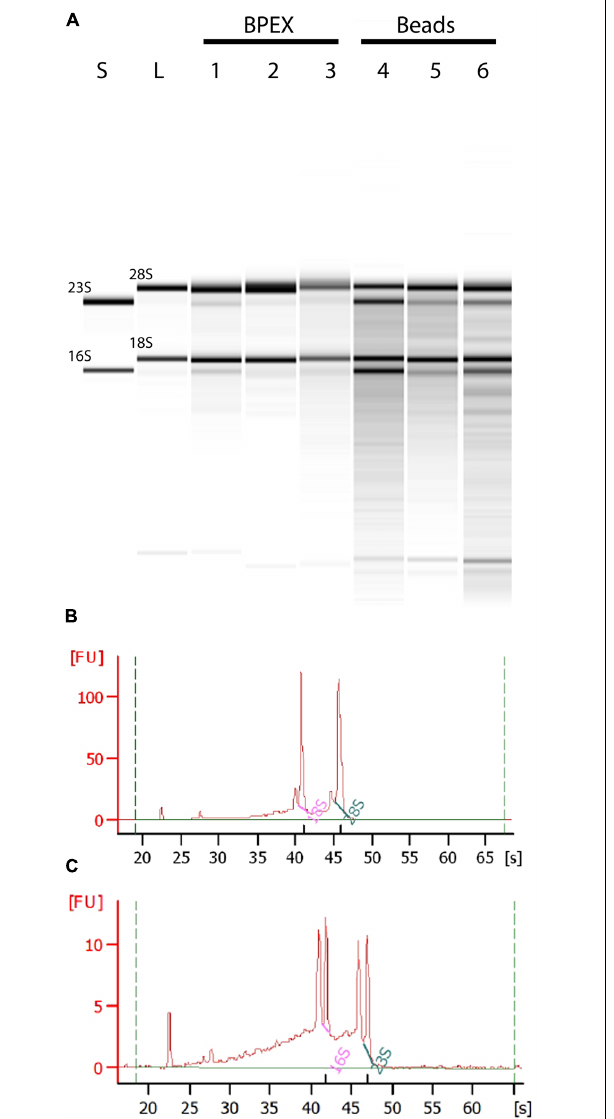
FIGURE 2 |Total RNA from plant root extractions by BPEX and Bead/SDS/phenol methods. Intact plant roots were suspended in 20 ml of bacterial inoculum (OD 600 of 0.2) for 2 h at 18 ◦ C.Total RNA was extracted using either the BPEX or the Bead/SDS/phenol method and